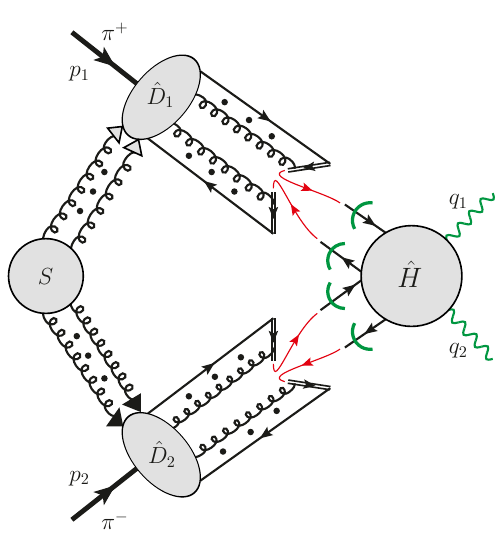
Figure 8. Factorization of longitudinally polarized collinear gluons to the H into the Wilson lines in the fundamental representation of the SU(3) color. The arrows on the Wilson line indicate the color flow. See text for the meaning of other